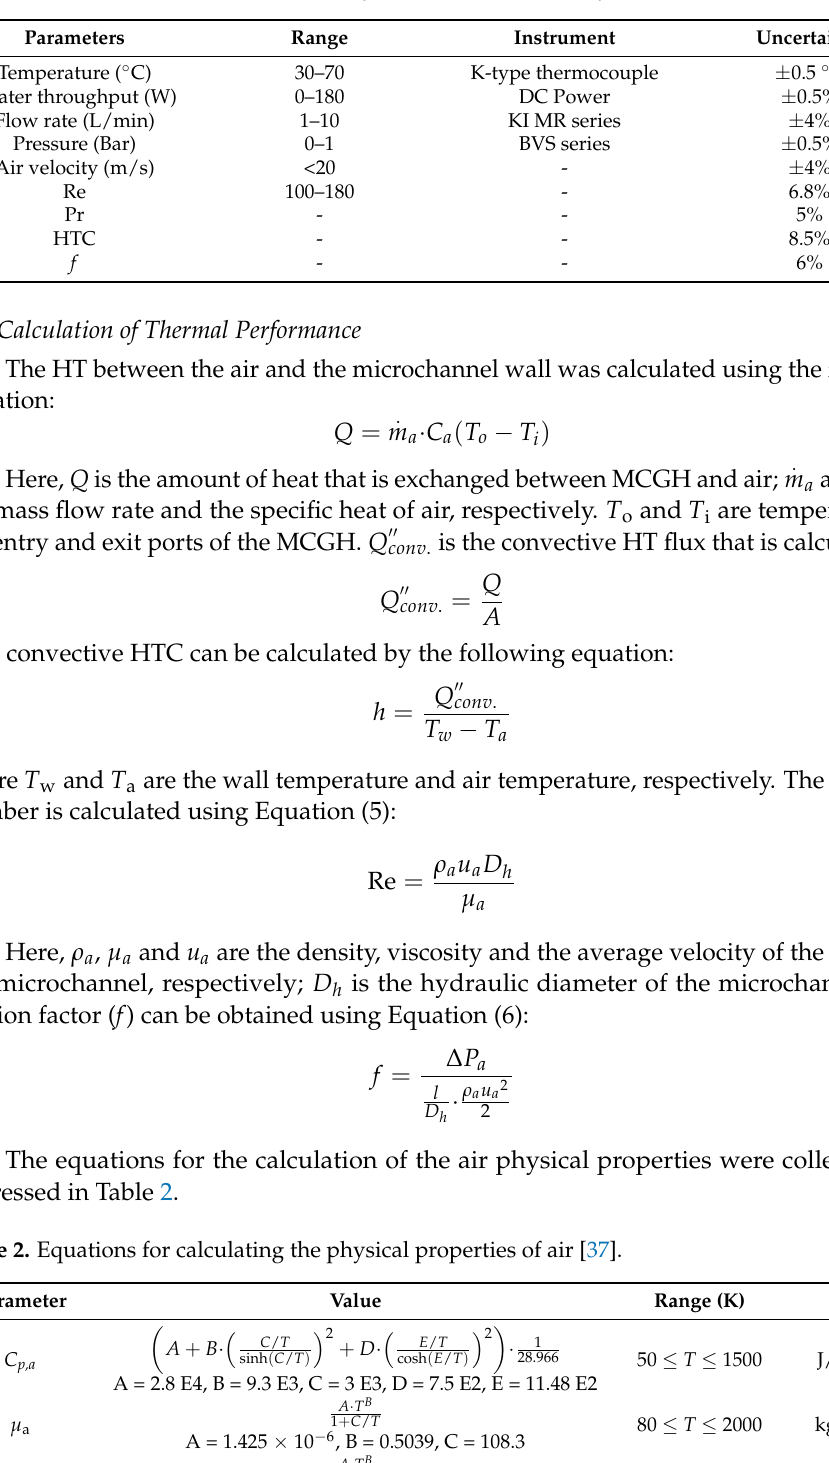
Table 1. The calculated and/or claimed-by-manufacturer accuracy of the instruments.